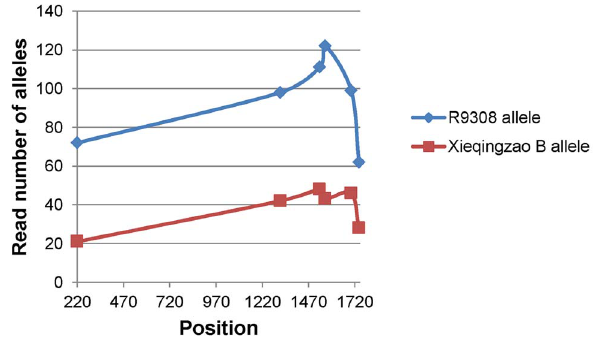
Figure 3. Relative proportion of SNP types in R9308 versus Xieqingzao B.